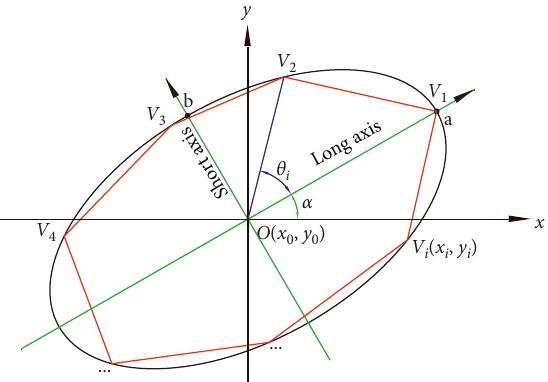
Figure 1: Typical granulometric curve of SRM.